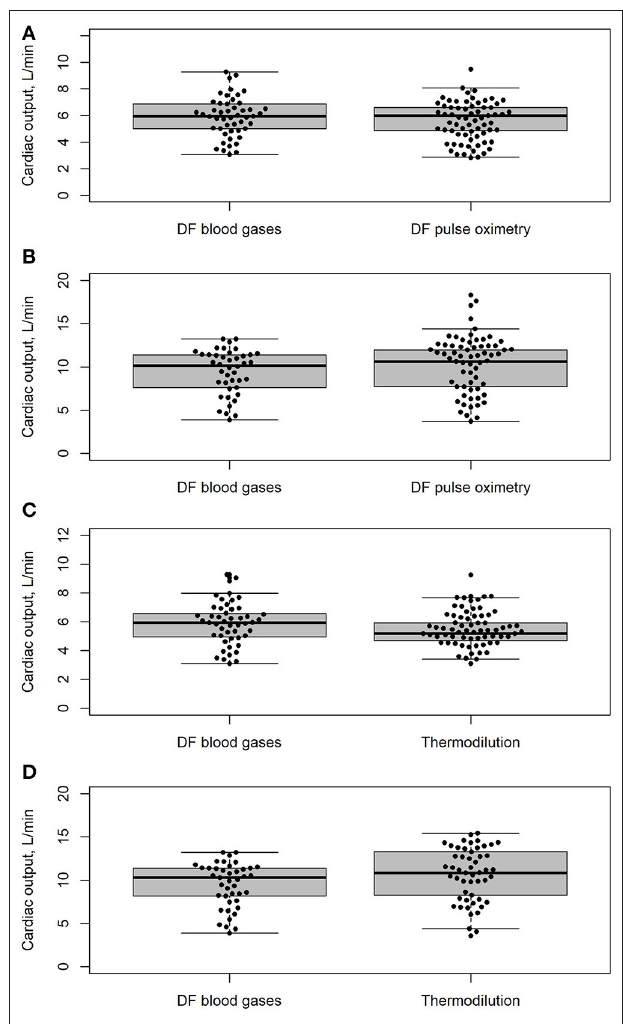
FIGURE 2 | Distribution of cardiac output (CO) measurements by different measurement methods at rest and end-exercise are shown as boxplots. The horizontal line represents the median, the box the 25th to 75th percentile, the whiskers 5th to 95th percentile, and the dots represent the individual values, including outliers. (A) CO measurement at rest: direct Fick using pulse oximetry (DFp) vs. direct Fick using blood gases (DF)*. (B) CO measurements at end-exercise: direct Fick using pulse oximetry (DFp) vs. direct Fick using blood gases (DF)*. (C) CO measurements at rest: intermittent thermodilution (TD) vs. direct Fick using blood gases (DF)*. (D) CO-measurements at end-exercise: intermittent thermodilution (TD) vs. direct Fick using blood gases (DF)*. *if the corresponding CO measurement was not available or missing, both measurements were